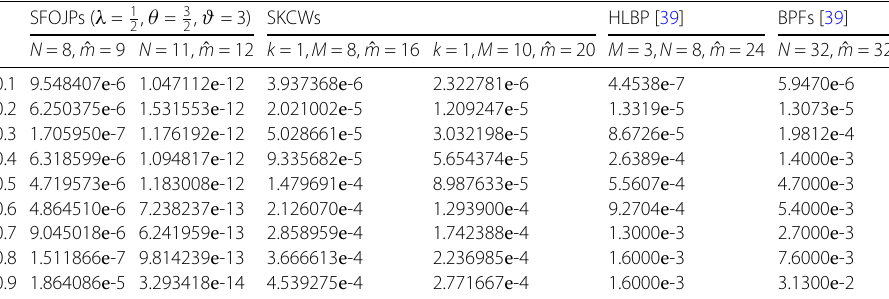
Table 2 Absolute errors at the interval [0,1), for Example